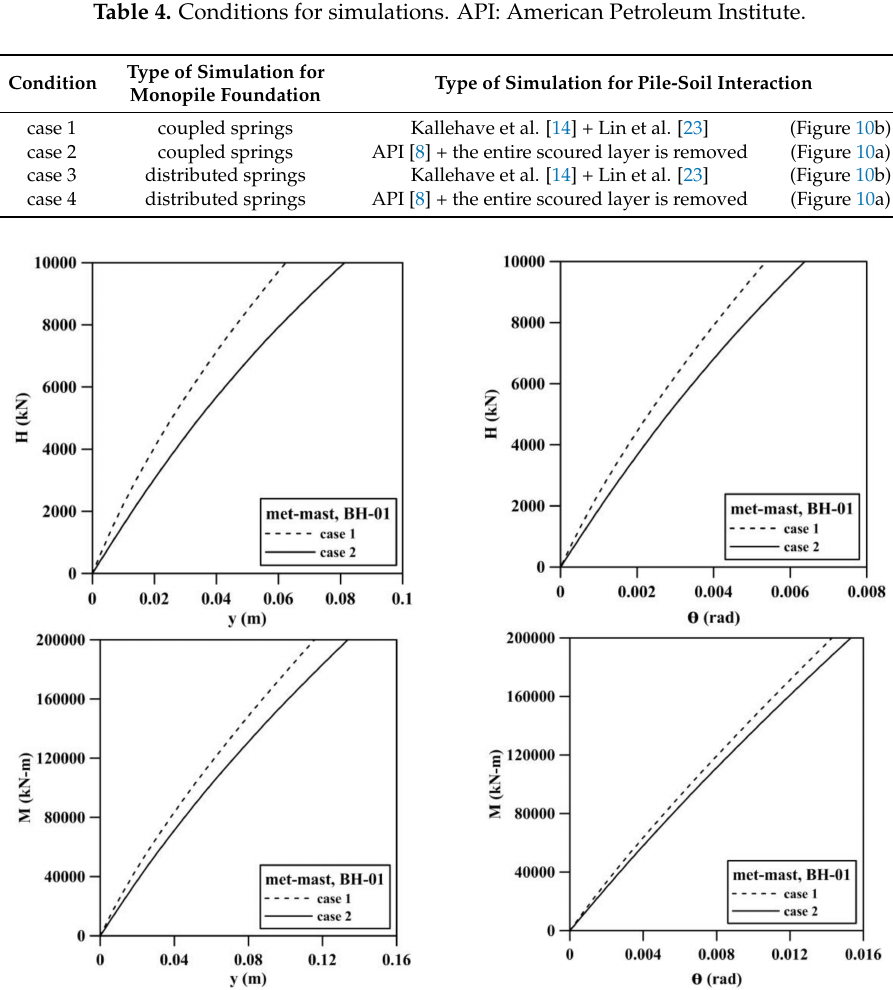
Figure 14. Load-deformation curves of pile head for met mast ( S d = 0 D ).